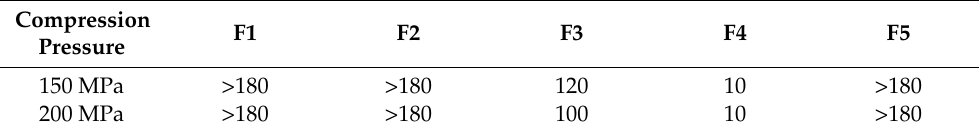
Table 2. Residence time (expressed in min) of tablets with resveratrol F1–F5 differed in compaction force to the porcine buccal mucosa ( n = 3;